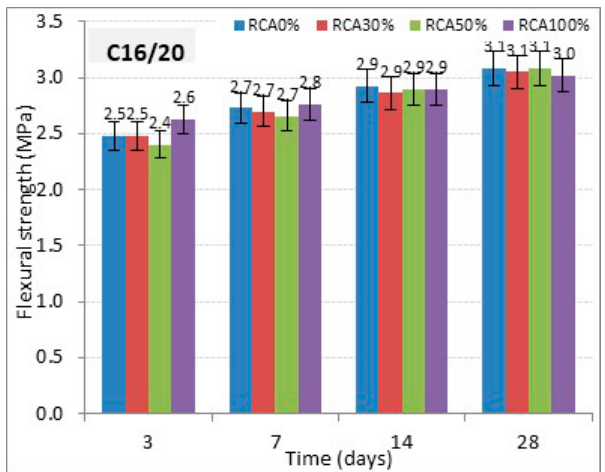
Figure 8. Effect of RCA content on the flexural strength development for C12/15 concretes.